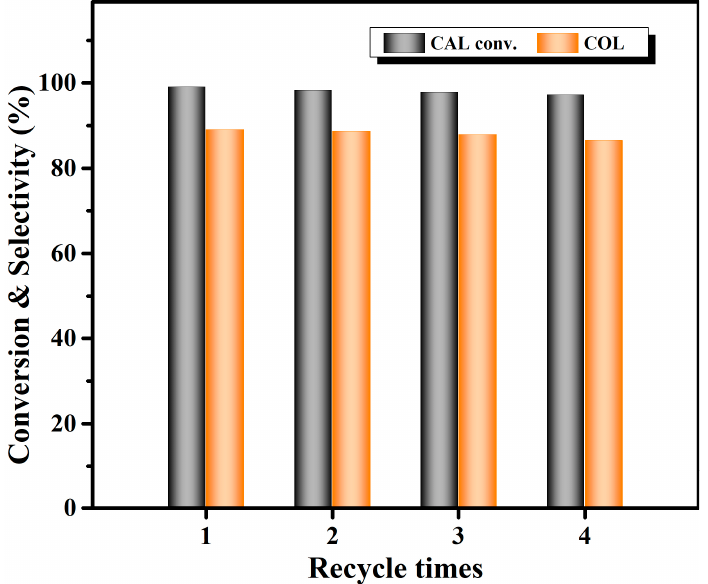
Figure 5. Recyclability of Co 1 Re 1 /TiO 2 catalyst. Reaction conditions: 3 mmol CAL, CAL:FA:Net 3 = 1:2:2, 10 mL THF, 80 mg catalyst, 140 °C, 4 h.